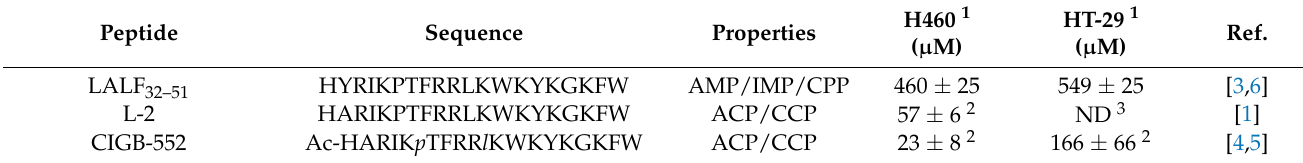
Table 1. CIGB-552 and analogs peptides biological properties and cytotoxicity.